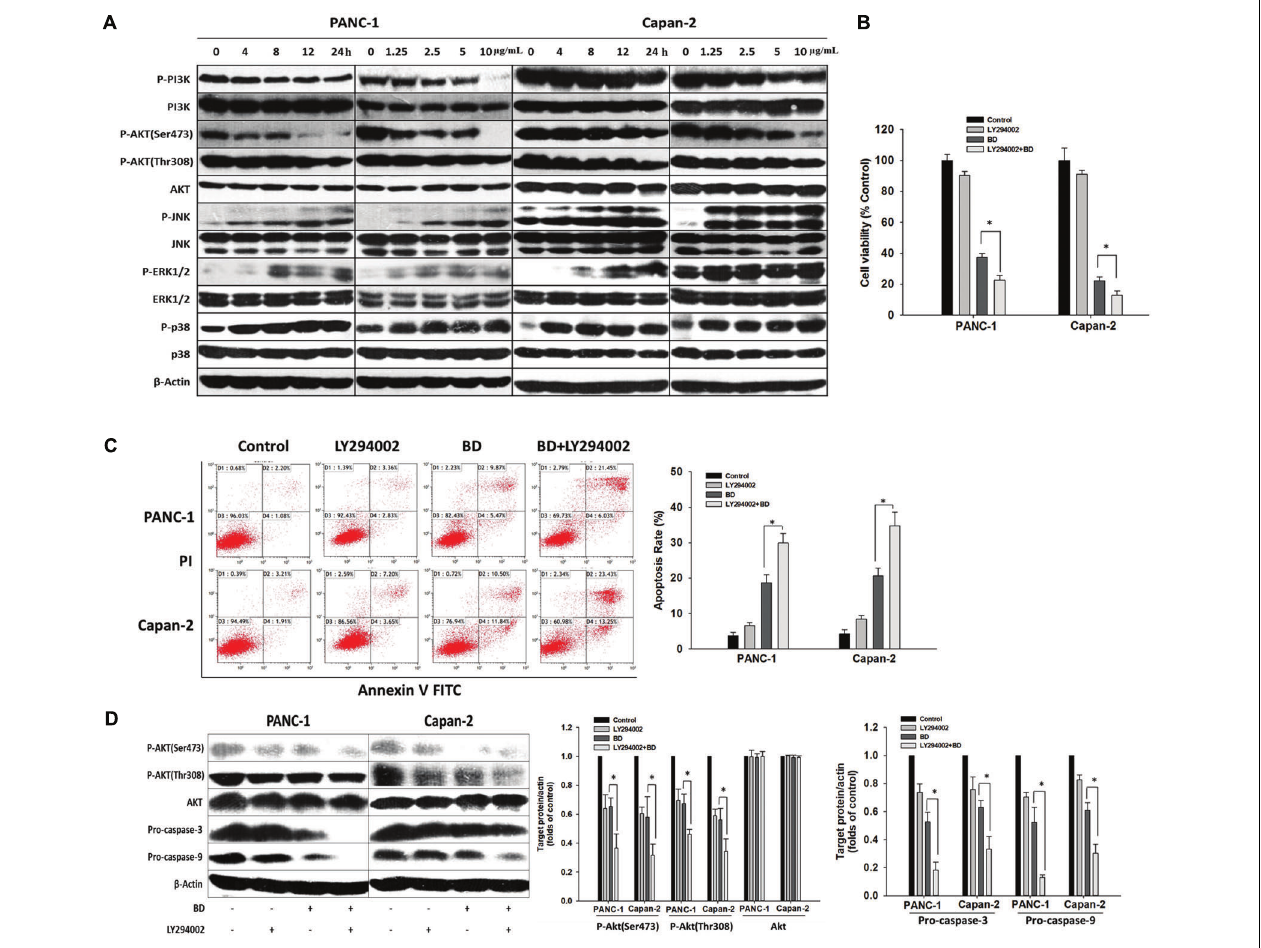
FIGURE 4 | The PI3K/Akt signal pathway is involved in BD-elicited PanCa apoptosis. (A) Cells were treated with various concentrations of BD (1.25, 2.5, 5, and 10 µ g/mL) for 12 h or BD at 5 µ g/mL for 4, 8, 12, and 24 h. Cells were harvested and then analyzed for the expression of PI3K/Akt and MAPK pathways-related proteins by Western blotting. β -Actin served as the protein loading control. (B) Cells were treated with BD for 72 h alone or in combination with pretreatment of 50 µ M LY-294002 for 1 h, respectively, and subjected to cell viability assay by MTT. (C) Cells were pretreated with LY-294002 (50 µ M) for 1 h, followed by 5 µ g/mL BD for 48 h. Flow cytometric analysis was performed by Annexin V-FITC and PI double-staining. (D) Cells were incubated with LY-294002 (50 µ M) for 1 h prior to BD treatment for another 12 h. The same amount of cell lysates was analyzed by Western blotting using antibodies against p-Akt, Akt, pro-caspase-3, and pro-caspase-9. β -Actin served as the loading control. Each bar represents means ± SD of three independent experiments, ∗ P <